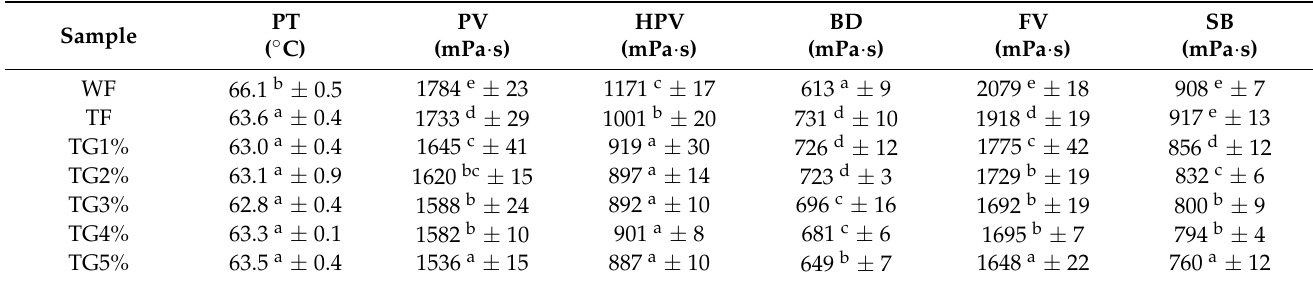
Table 3. Pasting characteristics of systems wheat flour, triticale flour and triticale flour with vi- tal